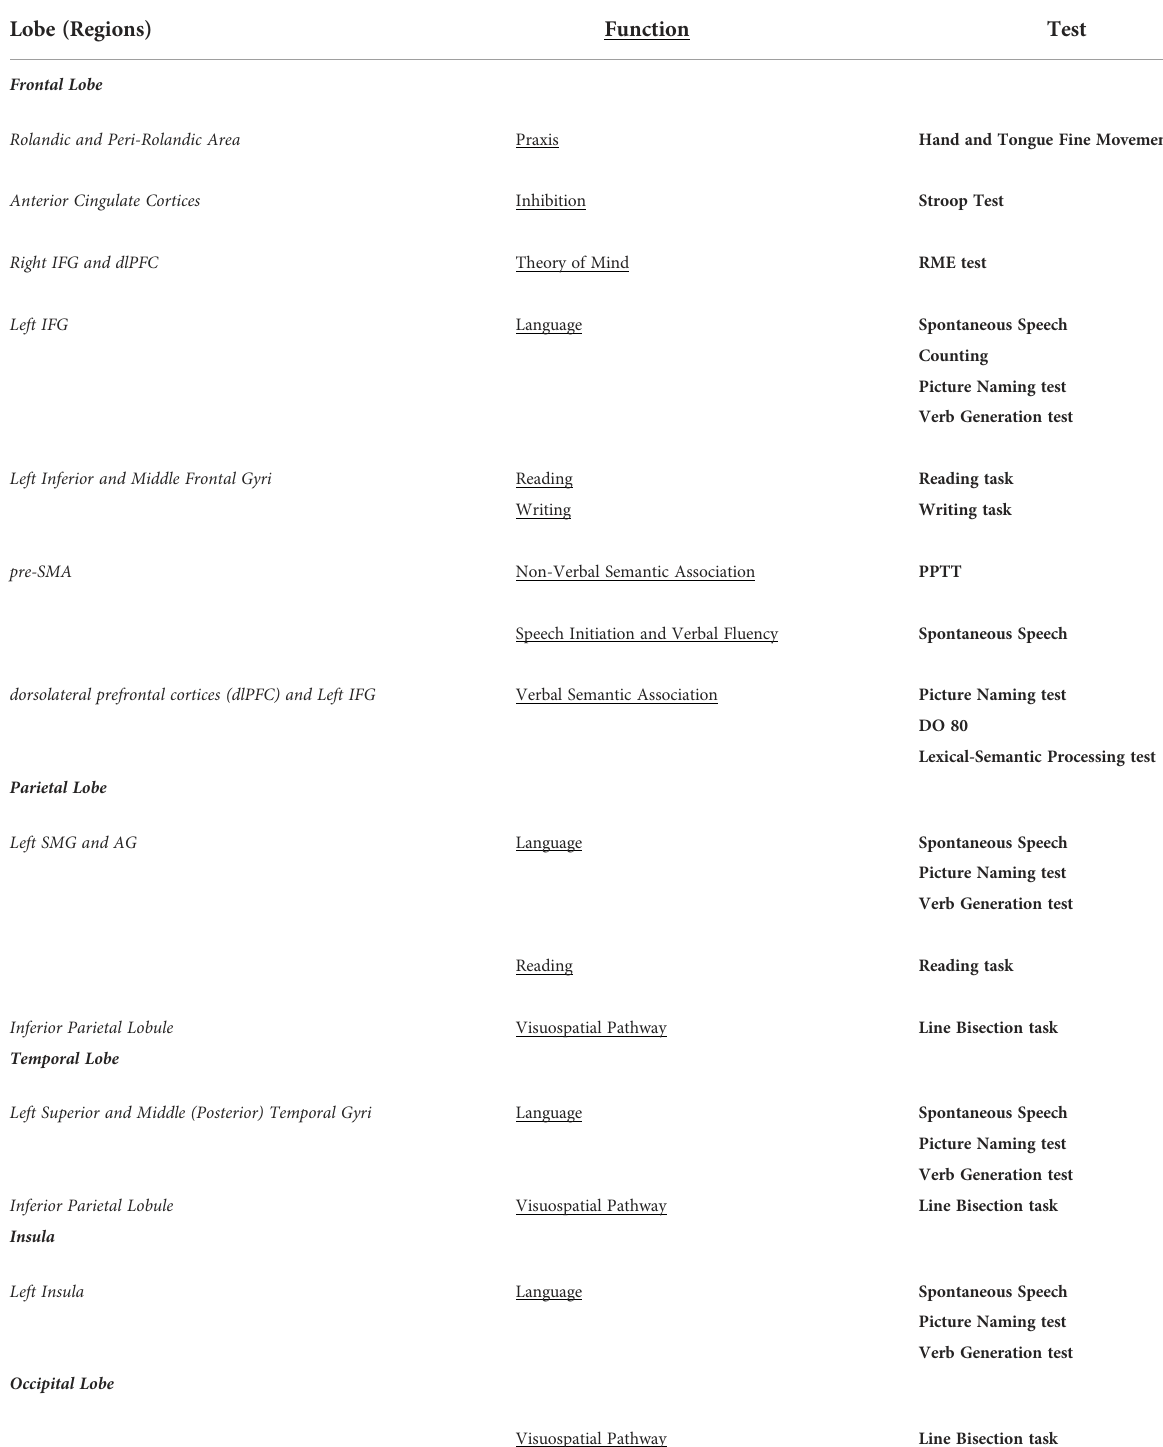
TABLE 2 Implemented intraoperative tasks and tested function being assessed in relation to speci fi c brain